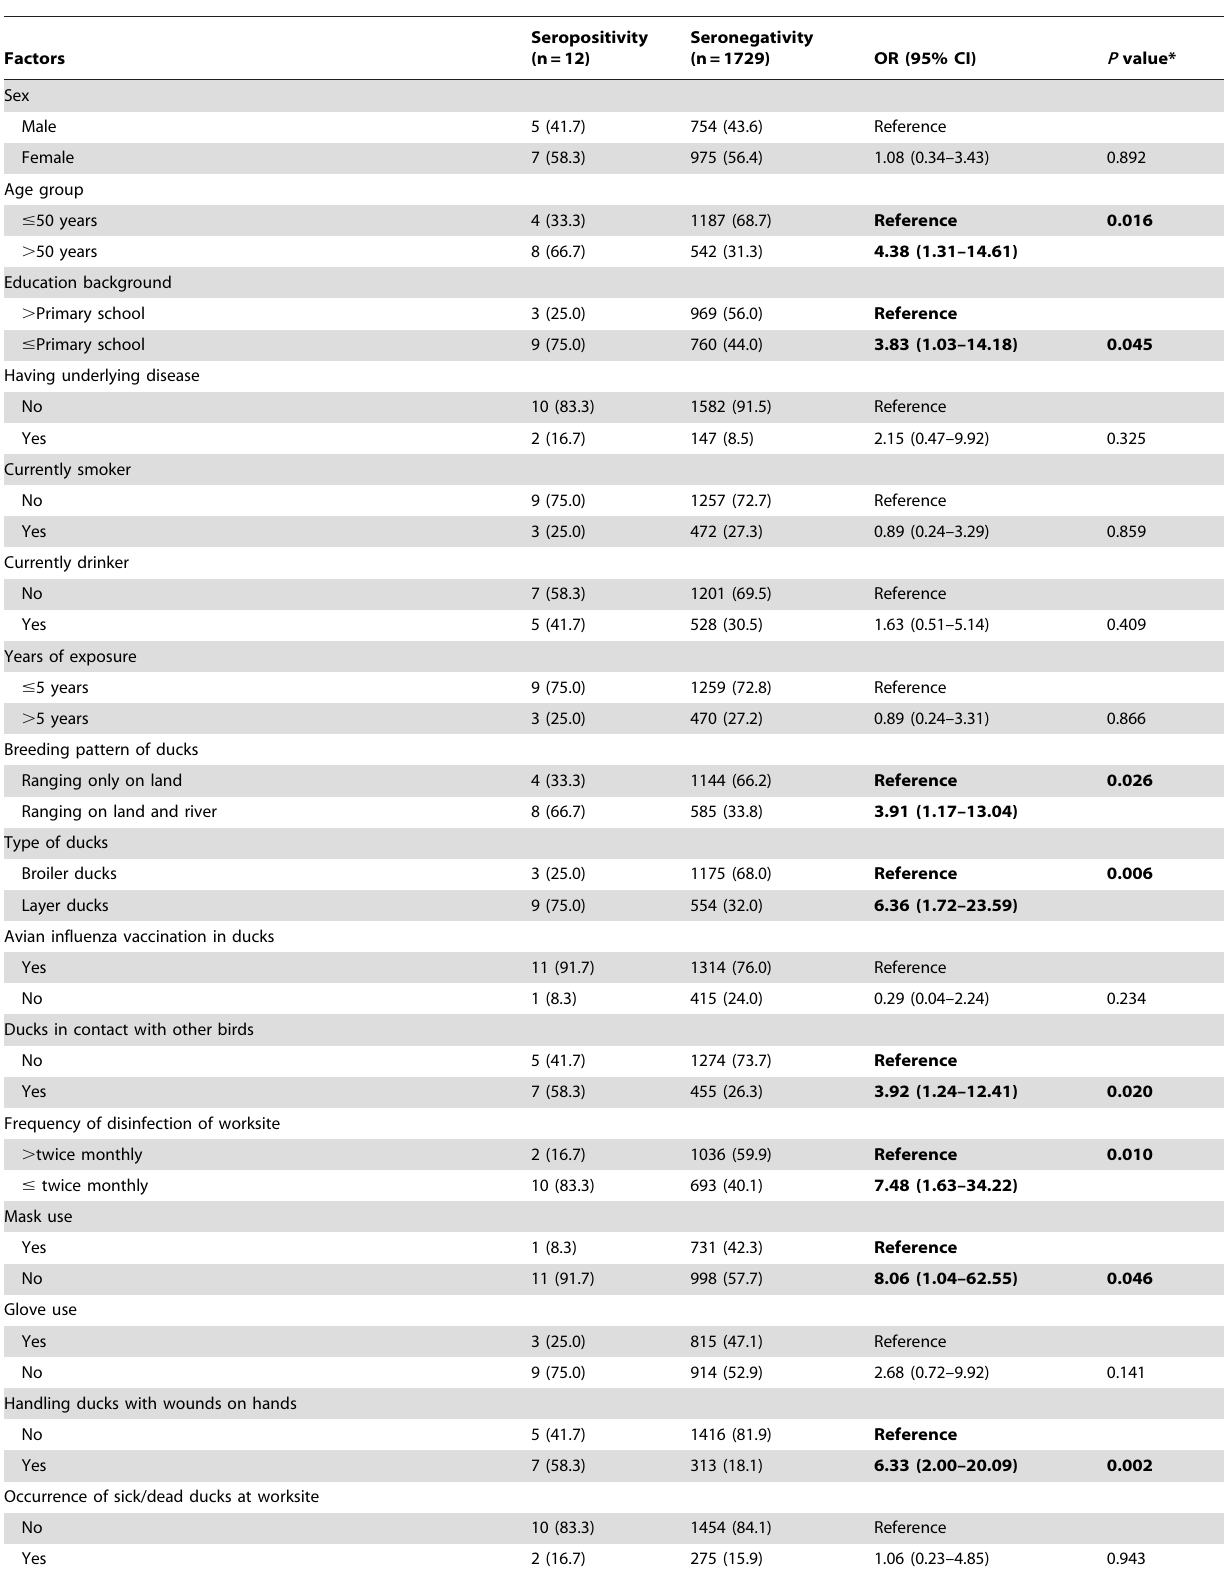
Table 3. Univariate analysis for risk factors associated with seropositivity for antibodies to H9 virus amongst duck-related workers, Beijing,